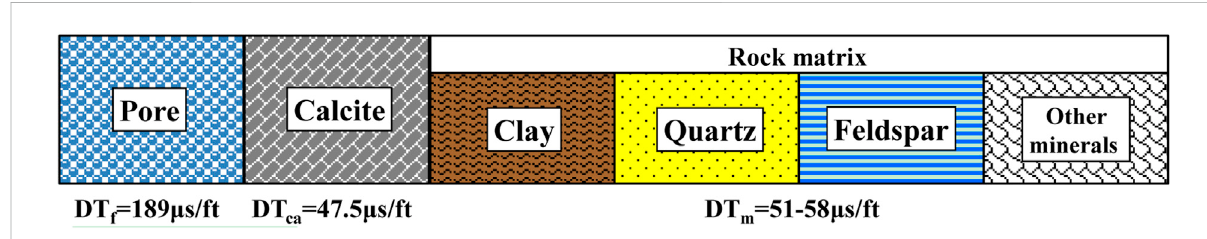
FIGURE 11 Petrophysical volume model of calcareous